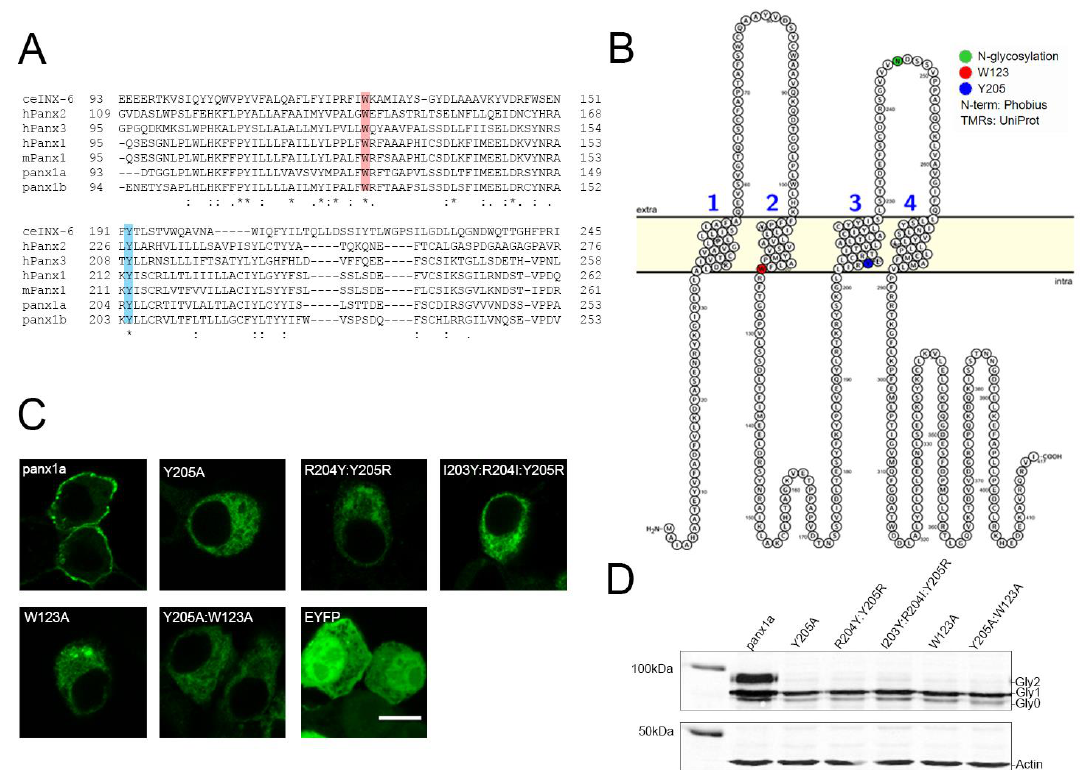
Figure 1. Expression and localization of panx1a WT and mutants in Neuro 2a cells. ( A ) Sequence alignment of panx1a with pannexin orthologs and paralogs and the Caenorhabditis elegans INX-6 protein. ( B ) Topological representation of a panx1a subunit showing the positions of both aromatic residues at the transmembrane and intracellular loop borders. The image was generated using Protter [27]. ( C ) Localization of EYFP-tagged wild type panx1a and mutants in transfected Neuro 2a cells. Scale bar: 10 µ m. ( D ) Western blot analysis of transfected EYFP-tagged panx1a and mutants. The three bands correspond to nonglycosylated panx1a (Gly0), the high mannose glycosylation (Gly1), and the complex glycosylation (Gly2) forms. Expressed proteins were detected using an anti-GFP antibody and an anti-ß-actin antibody as the